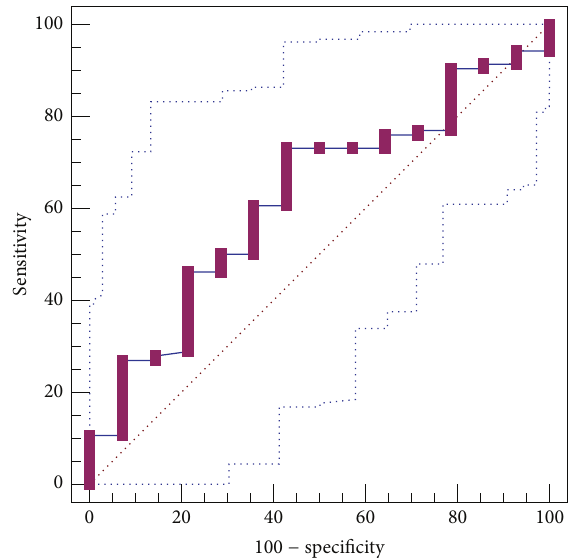
Figure 3: ROC curve analysis to identify the discriminative capacity of PIIINP level in predicting the presence of GEVs in liver cirrhosis.